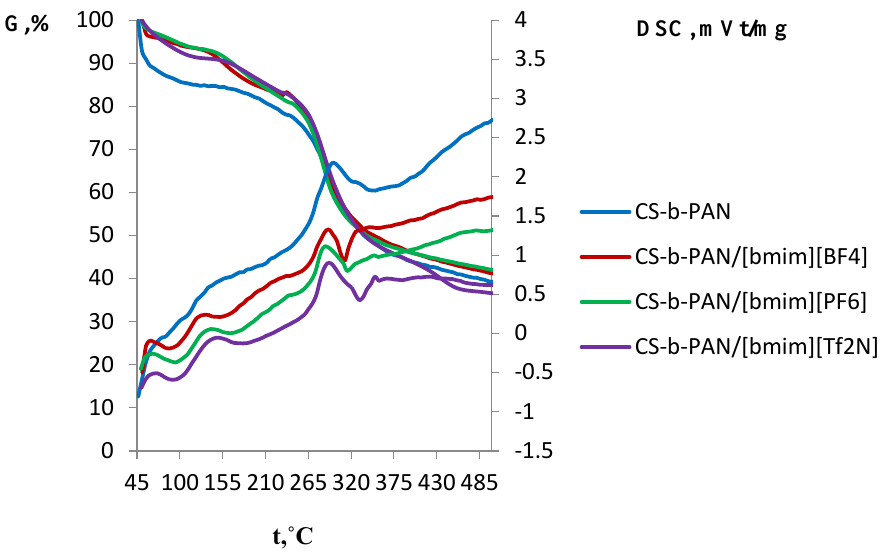
Figure 8. DSC and TGA curves of CS-g-PAN, CS-b-PAN, and CS-b-PS copolymers.